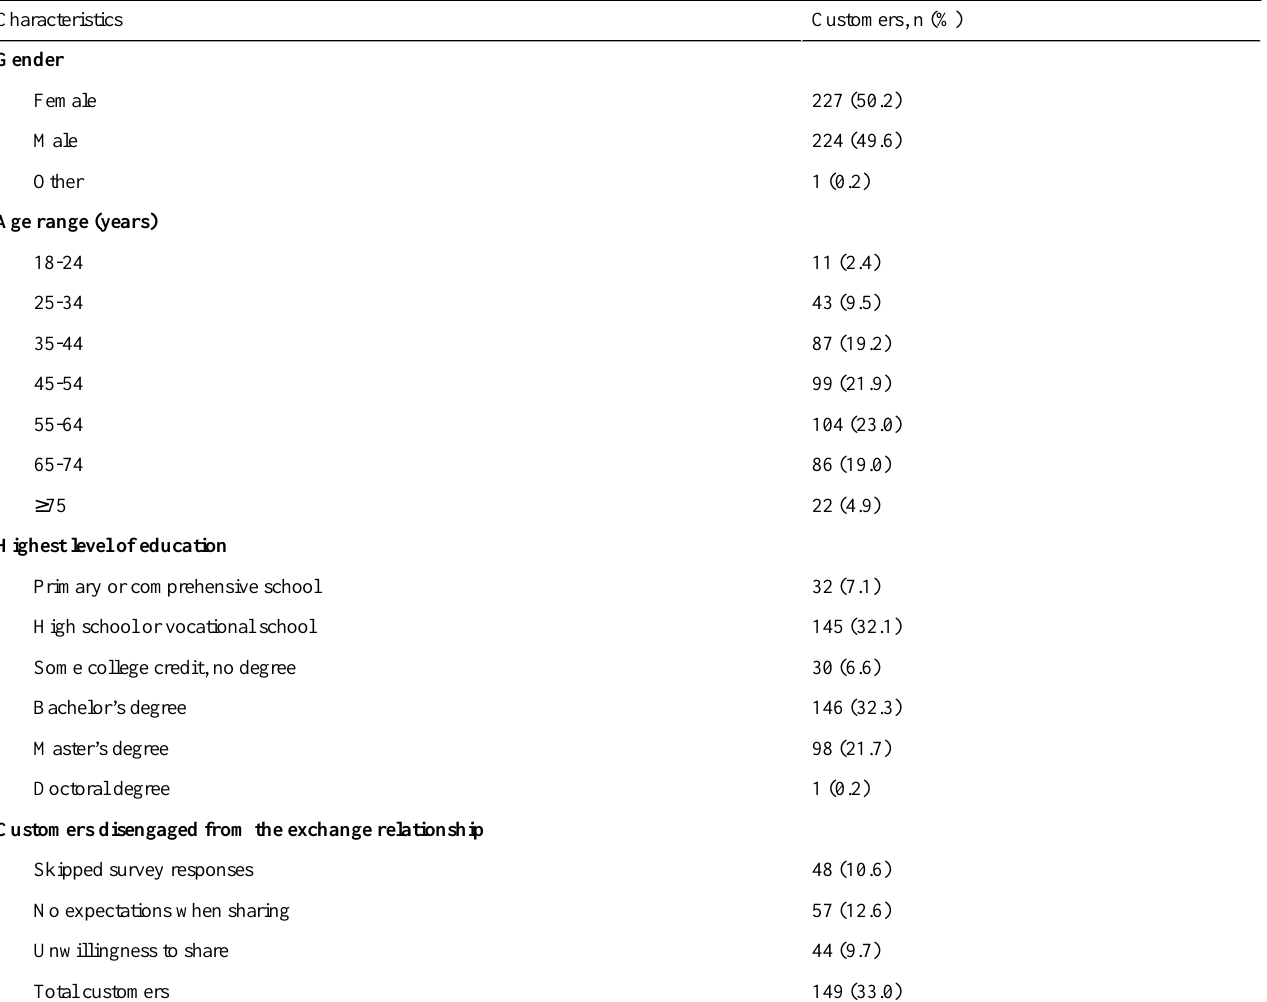
Table 2. Customer characteristics representing the number of customers (N=452) and their reported gender, age, and highest level of education. Customers disengaged from the exchange relationship are also